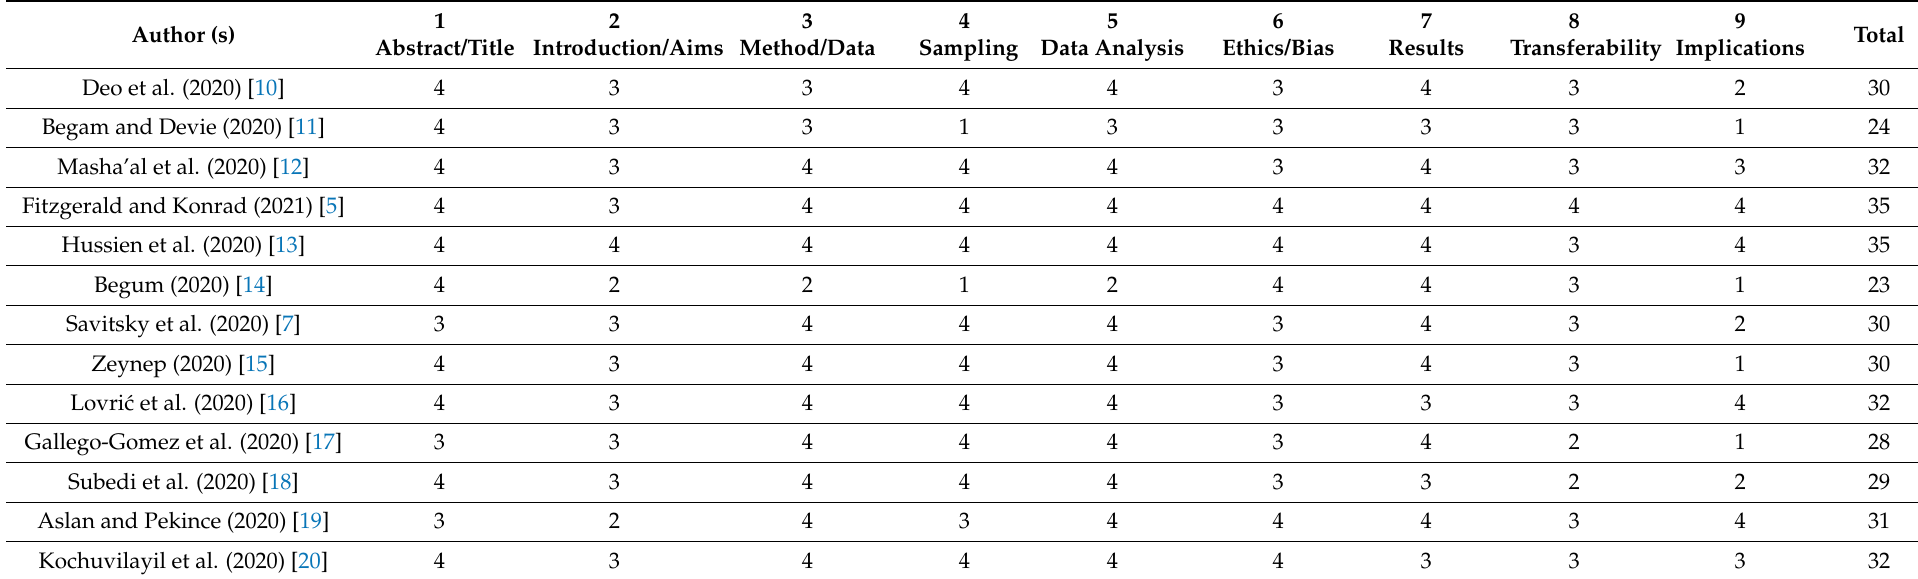
Table 2. Quality-approved total score allocation. Maximum score =